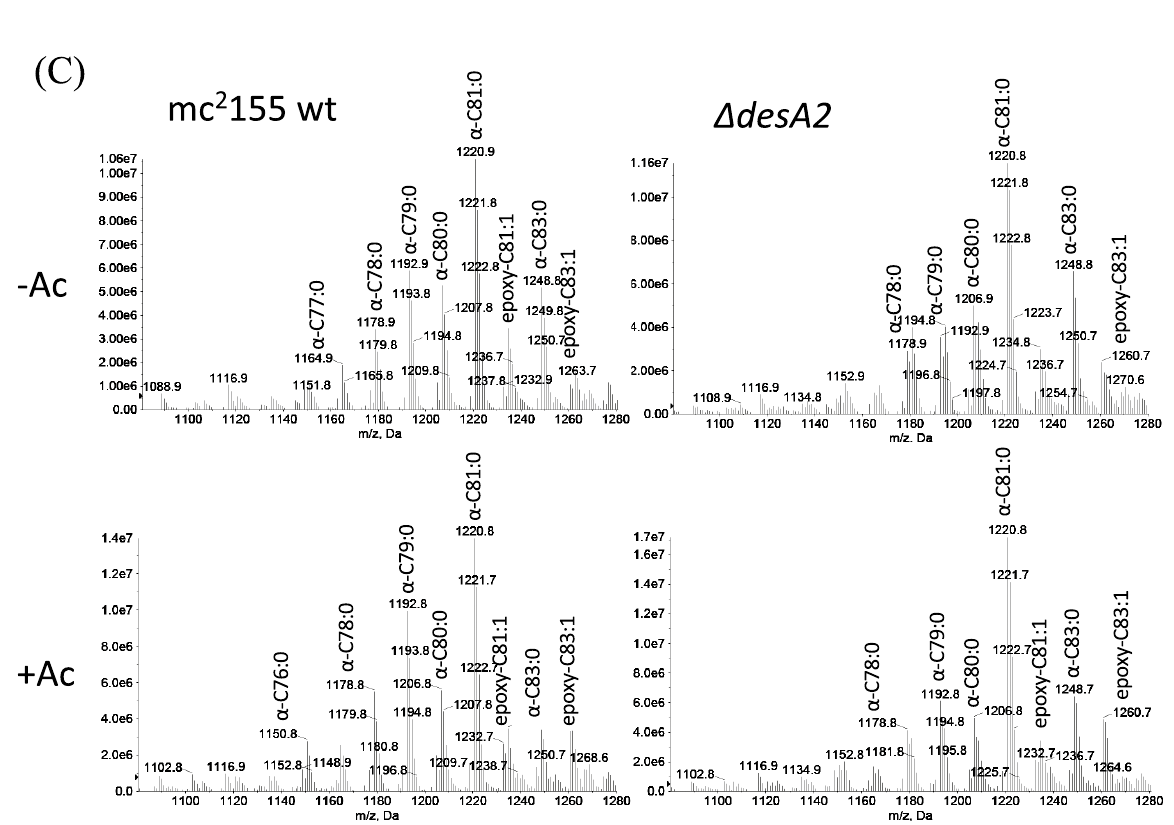
Figure 4. ( A ) Autoradiographs of two-dimension silver TLC plates used to separate [ 14 C]-labelled fatty acid methyl esters (FAMEs) and mycolic acid methyl esters (MAMEs) extracted from the ∆ desA2 mutant. Ac; acetamide ( B ) Densitometric quantification of mycolic acid subspecies shown in ( A ). Comparative values shown for each subspecies, with those for − Ac cultures expressed as a percentage of those from + Ac cultures. ( C ) ESI– MS of MAMES extracted from the ∆ desA2